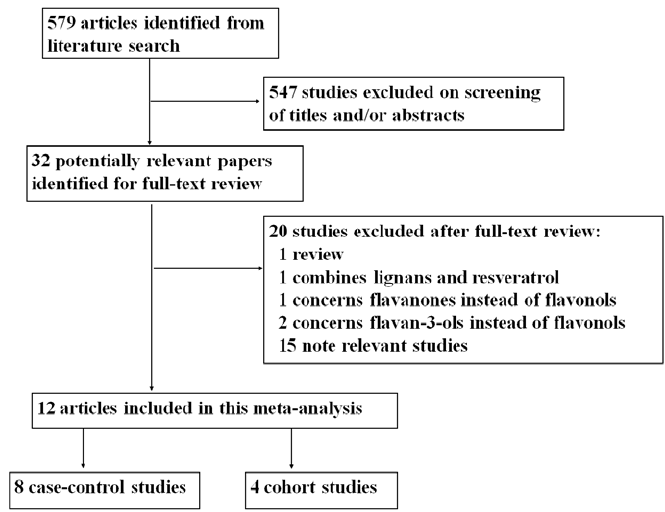
Figure 1. Flow chart showing the study selection procedure.